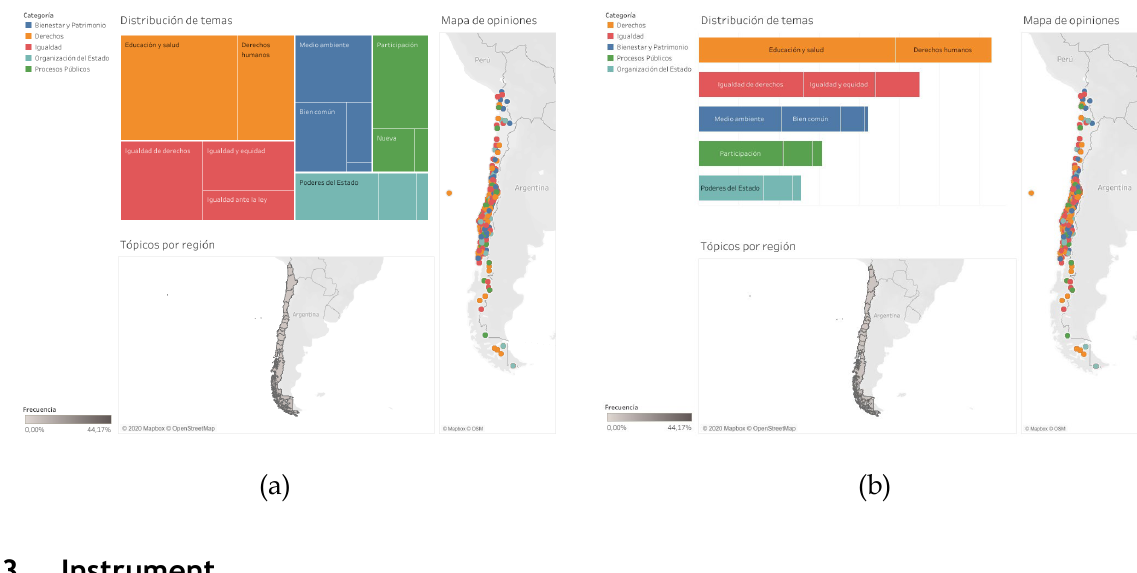
Figure 1: User interface for the exploration of the model of topics on the opinions of the citizen consultation of the 2016 constituent process in Chile. (a) Interface A: tree map + choropleth map + point density map; (b) Interface B: stacked barchart + choropleth map + point density